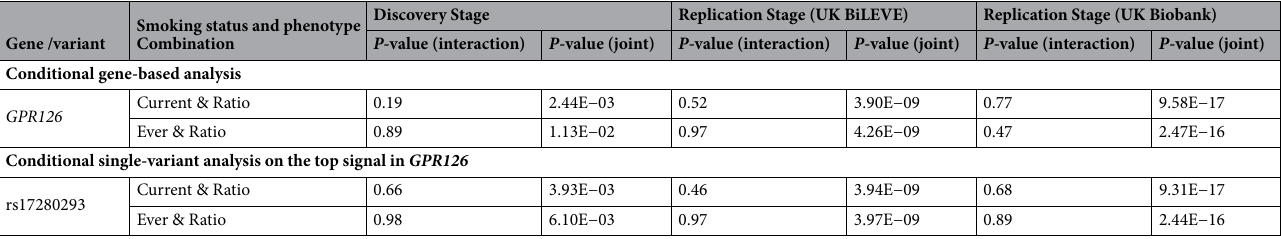
Table 3. Conditional analysis of GPR126 (adjusting for a common variant rs3817928).